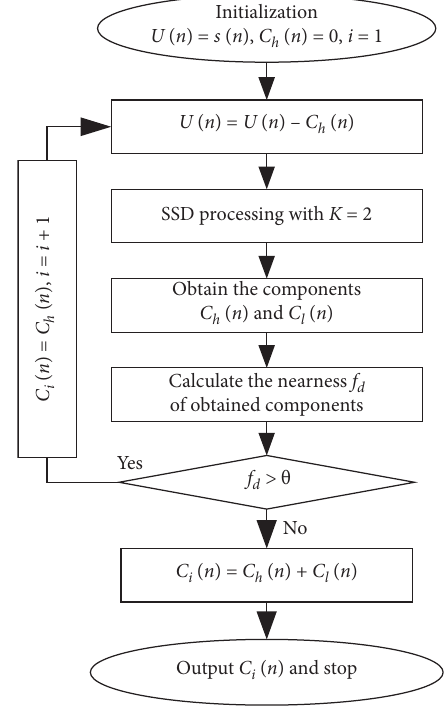
Figure 2: Flowchart of